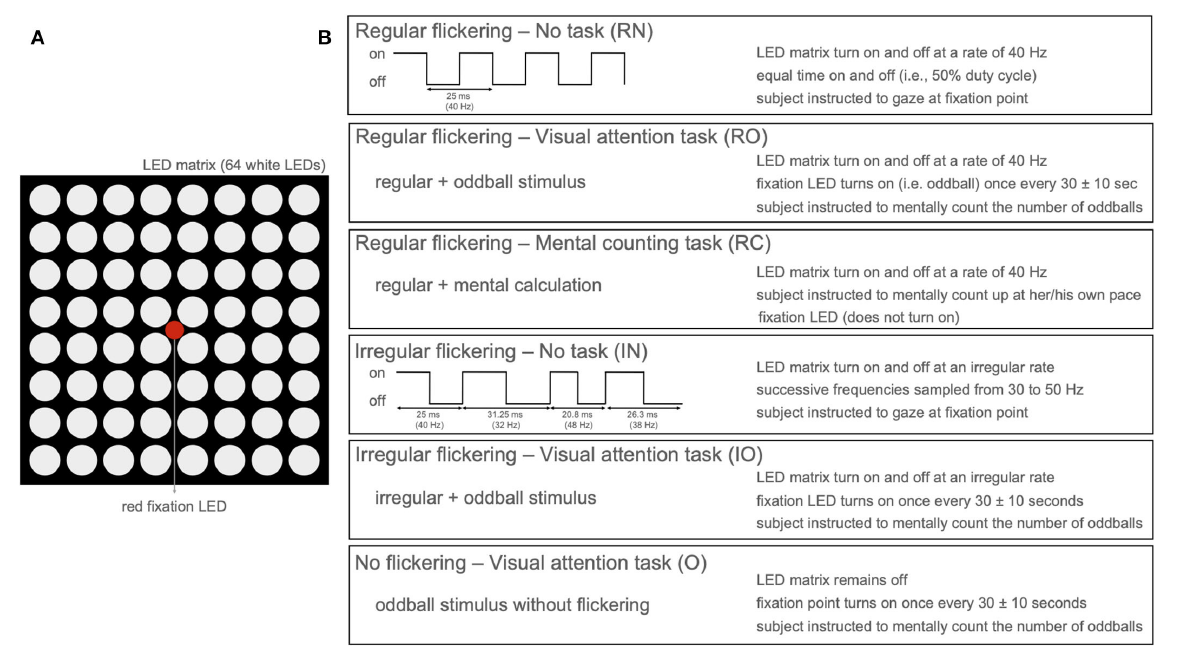
FIGURE1 (A) LED arrangement of the stimulation device with 8 × 8 LED matrix with a single red fixation LED in the center. (B) Stimulation paradigm per condition presenting five conditions with active flickering stimulation (LED matrix on) and one condition with only oddball paradigm without flickering stimulation (only red LED active).